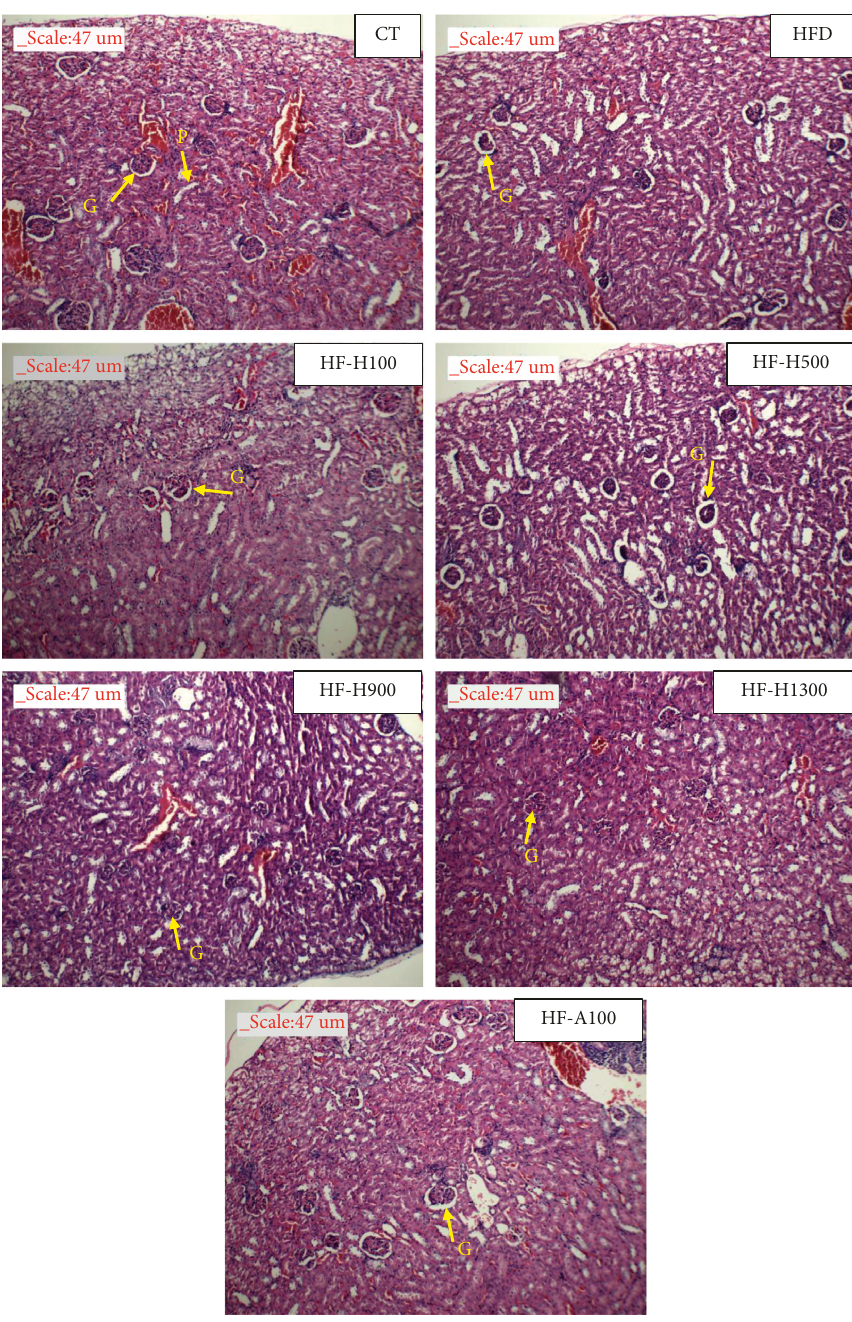
Figure 7: Photomicrographs of key tissues (G: glomerulus; P: proximal convoluted